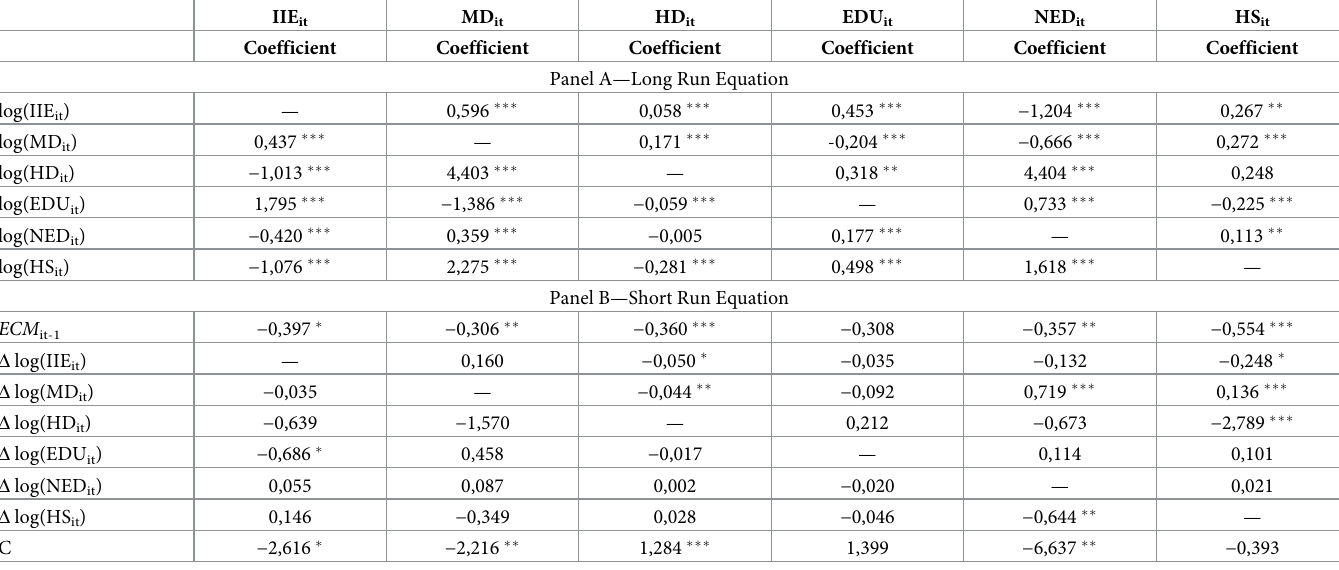
Table 5. PMG estimation results for panel of CEE countries (panel ARDL models)—Annual